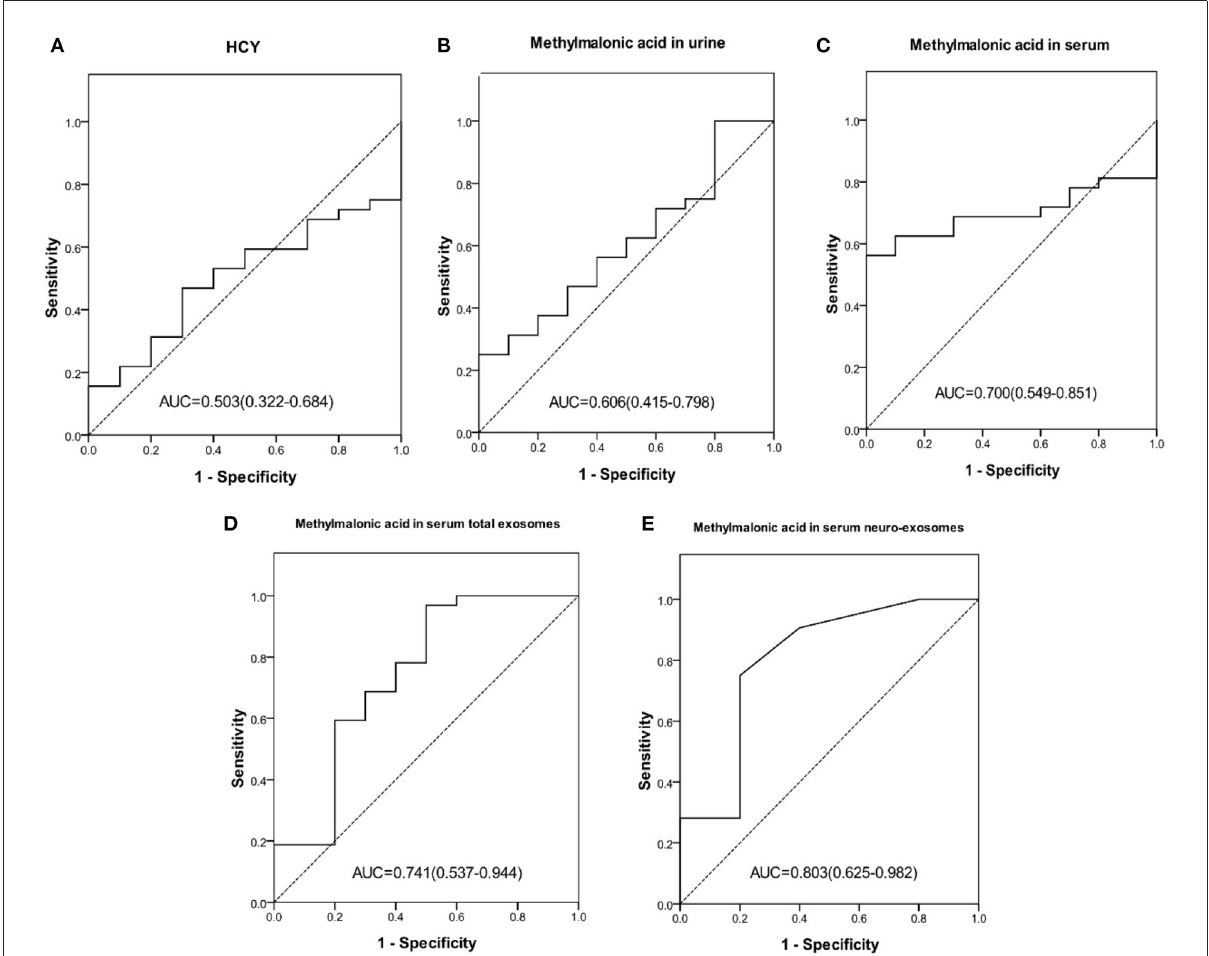
FIGURE3 ROC curve of HCY in serum (A) , methylmalonic acid in urine (B) , methylmalonic acid in serum (C) , methylmalonic acid in serum total exosomes (D) , methylmalonic acid in serum neuro-exosomes (E) individually for distinguishing cblC-MMA children with cognitive impairment from without cognitive impairment. ROC, receiver operating characteristic; HCY, homocysteine; neuro-exosomes, neuronal-derived